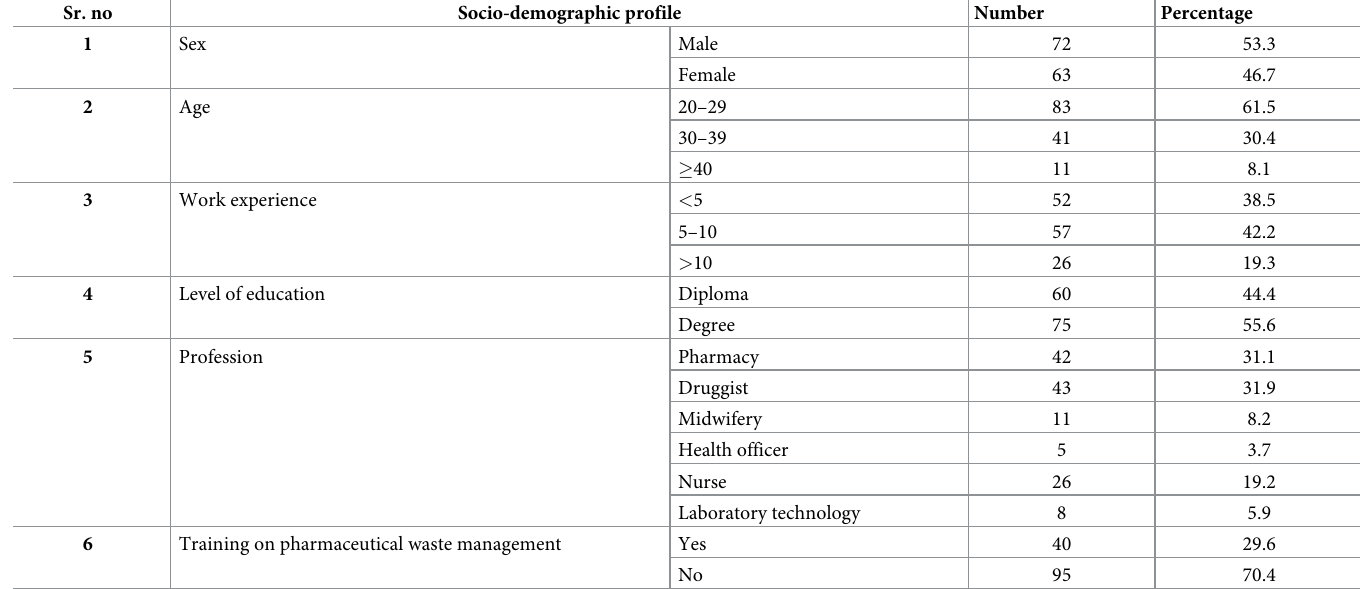
Table 4. Socio-demographic characteristics of health professionals in public health facilities of Dessie town, Ethiopia (n = 135). Sr.